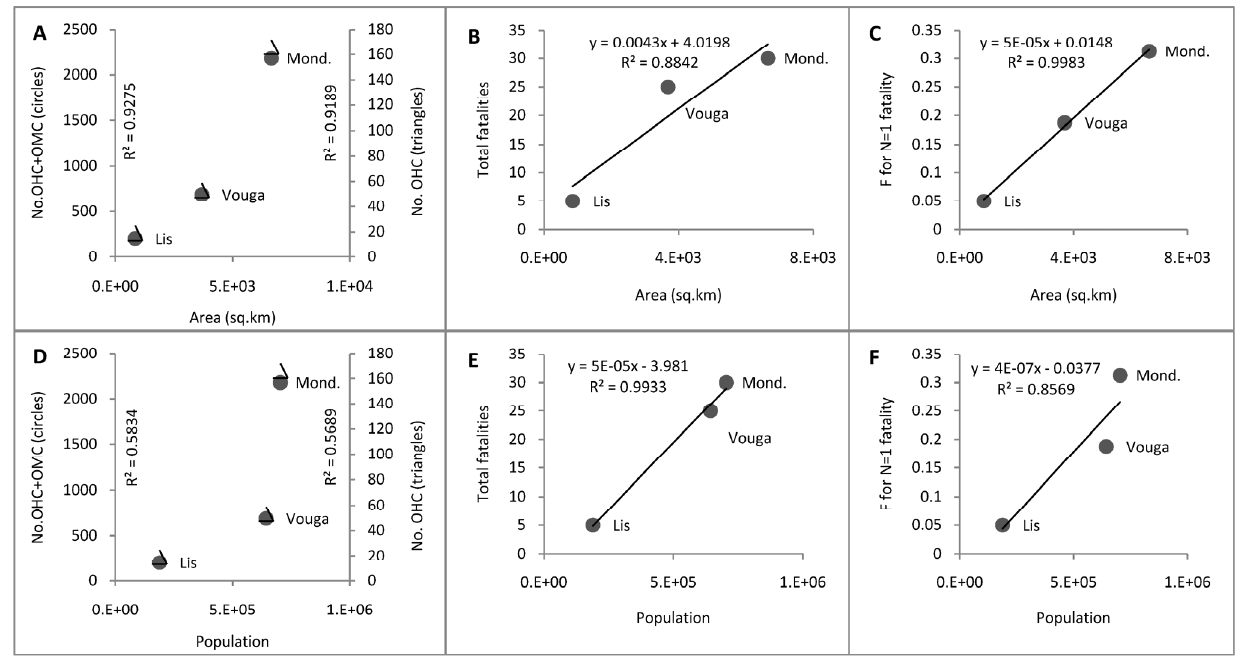
Figure 9. Relation between area and population and the number of occurrences ( A , D ); the number of fatalities (D & D persons) ( B , E ); and the frequency of occurrences with one fatality ( C , F